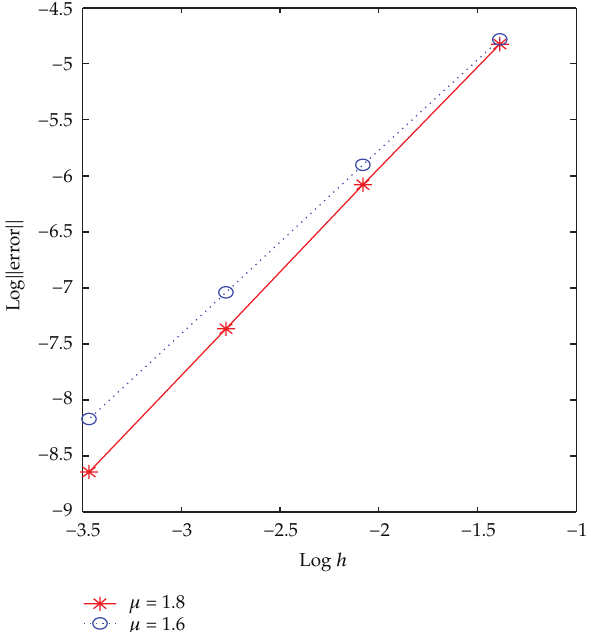
Figure 2: Log-log plots of the error for the rate of